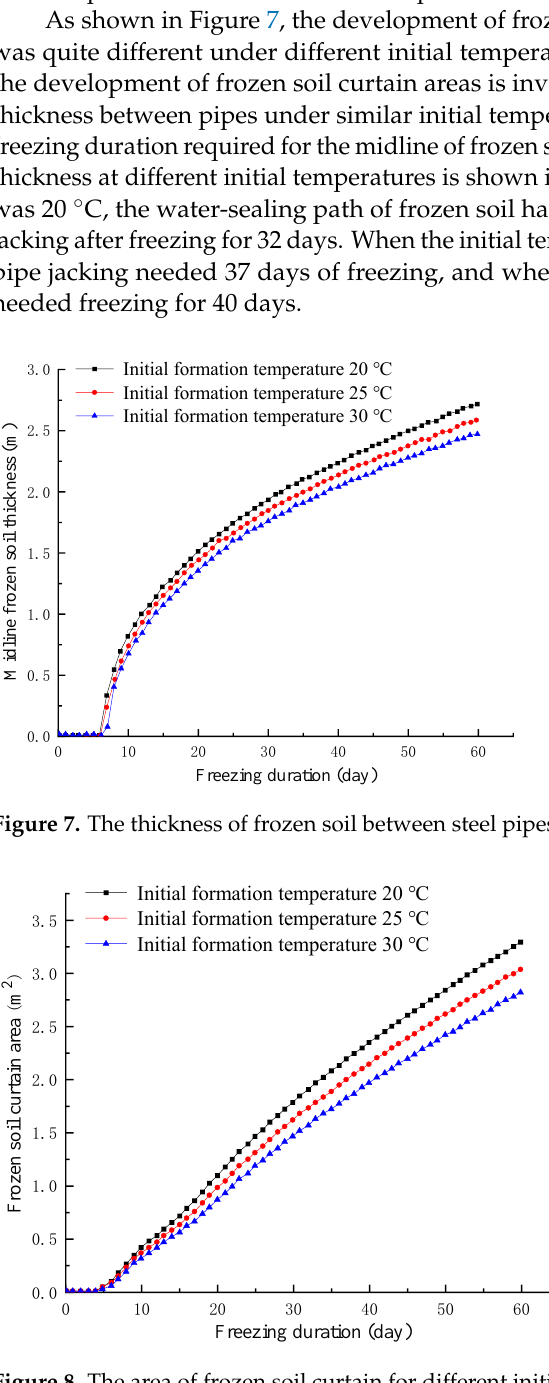
Figure 8. The area of frozen soil curtain for different initial formation temperatures. Table 8. Freezing duration of the frozen soil thickness midline at different initial temperatures (day). Midline Thickness of Frozensoil (m)